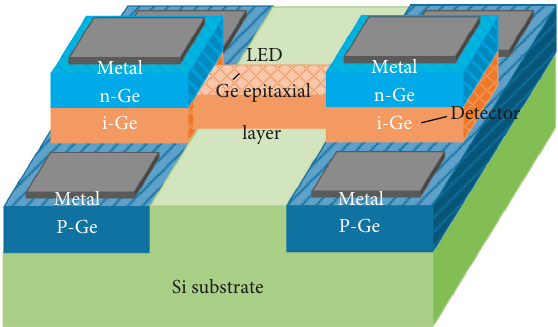
Figure 1: A diagram view of the MOEI